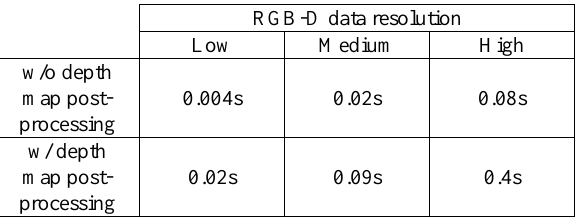
Table 2. Computational time of our method for a single view